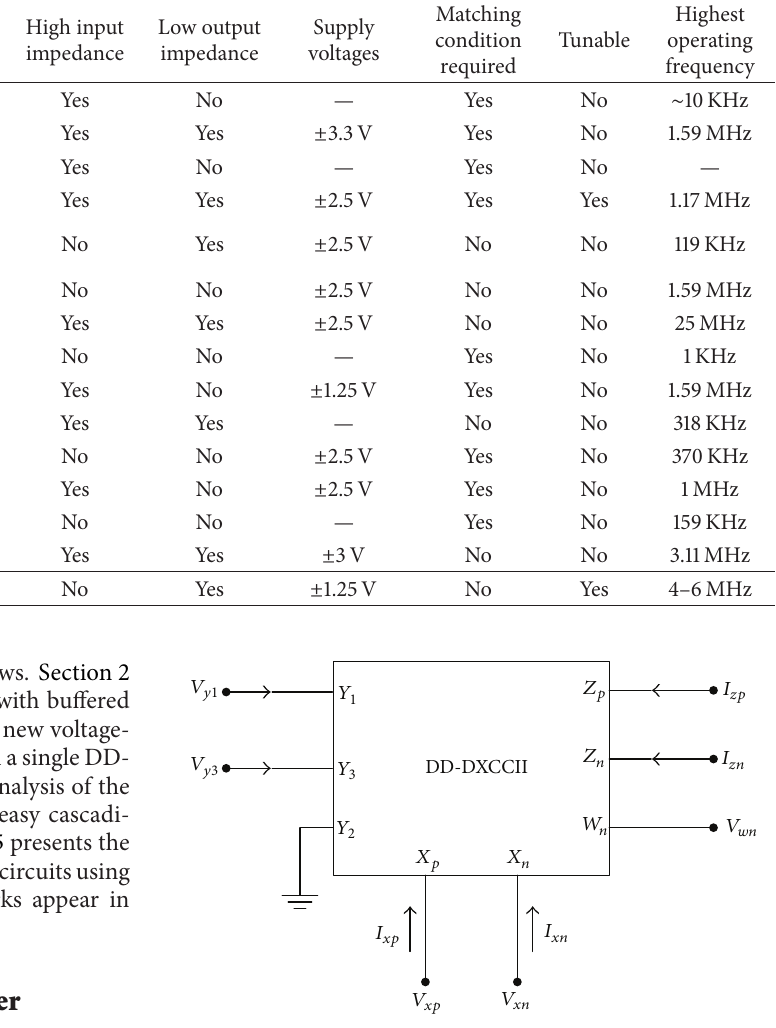
Figure 1: Schematic symbol of